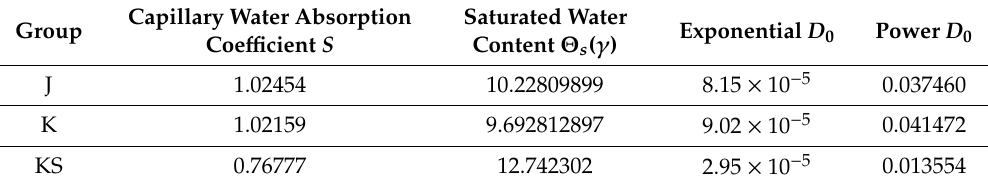
Figure 5. Saturation of water absorption process. Table 5. D 0 values of exponential and power